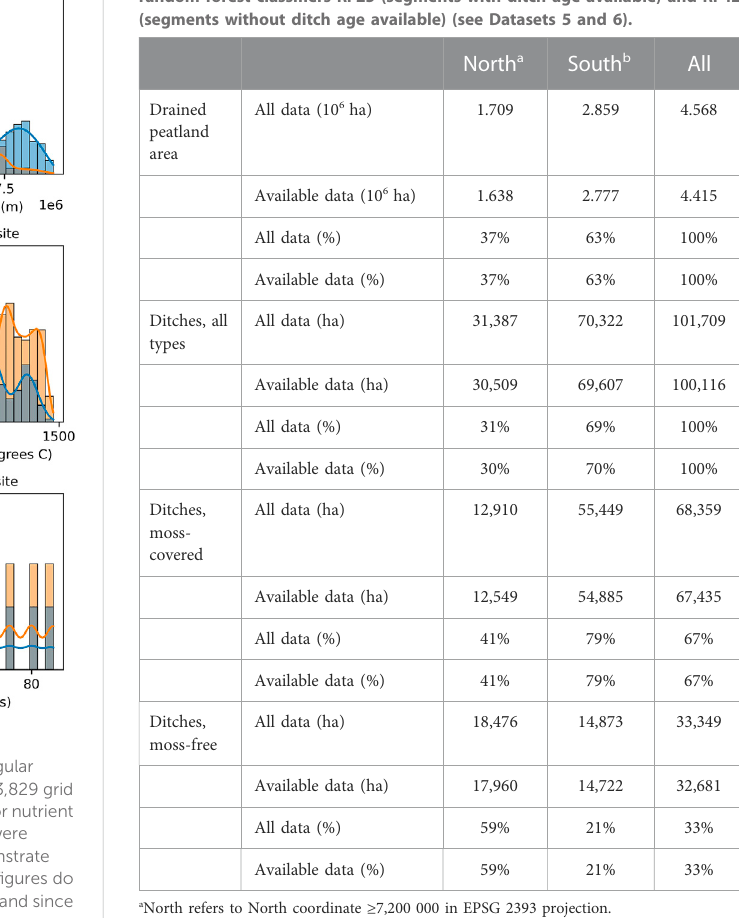
TABLE 4 Drained peatland areas and ditch areas in all segmented data and within the data where parameters were available for application for